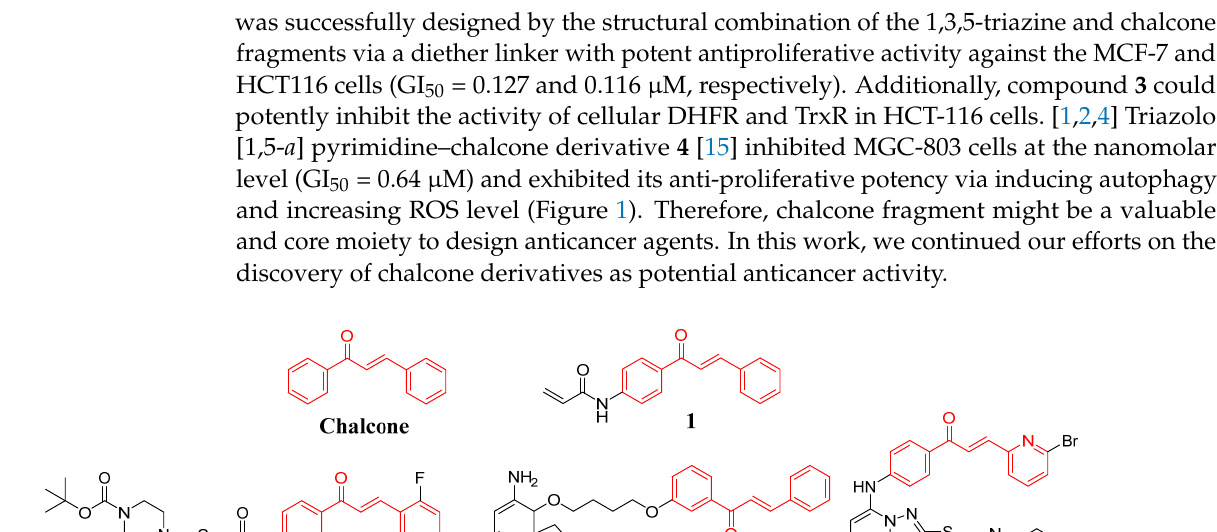
Figure 3. Design of novel quinoline-chalcone derivatives as anticancer agents. 2. Results and Discussion 2.1. Chemistry Target quinoline-chalcone derivatives were synthesized by outlined procedures in Scheme 1. Commercially available 4-aminoacetophenone ( 8 ) reacted with aromatic alde- hydes 9a – 9j to afford compounds 10a – 10j in the presence of NaOH in EtOH at 25 °C. Substitution reaction between compounds 10a – 10j with commercially available 4-chloro- 2-methylquinoline ( 11 ) gave target compounds 12a – 12j in the presence of HCl in EtOH at 80 °C. In addition, Compounds 12a , 12b , 12e , and 12f then reacted with iodomethane or iodoethane in the presence of KOH in acetonitrile at 80 °C to give compounds 13a – 13f . All the compounds were characterized by means of NMR and HREI-mass spectra which are showed in the Supplementary Materials.